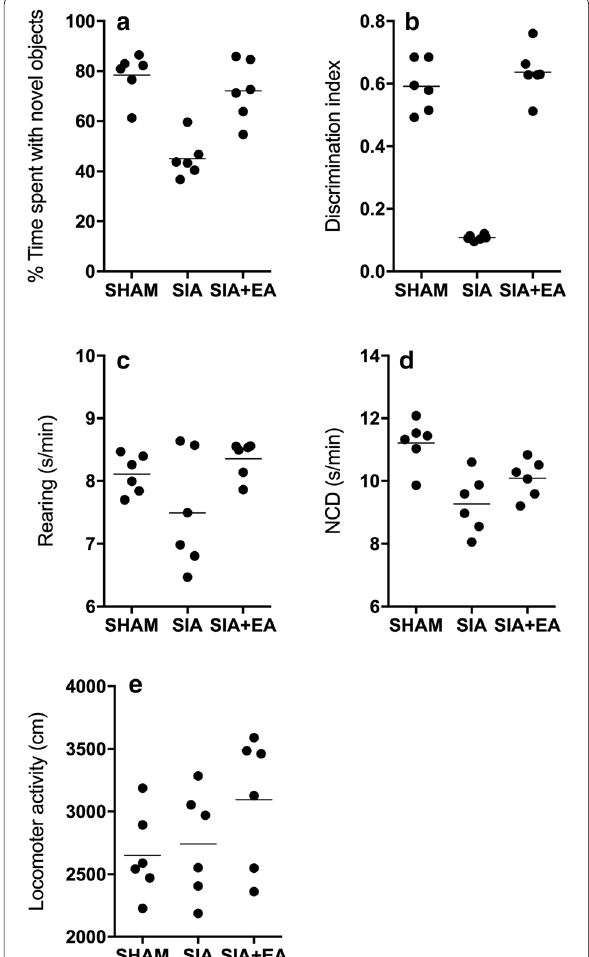
Fig. 3 EA treatment improved memory consolidation in SIA rats (NOR test; Technical repeats n